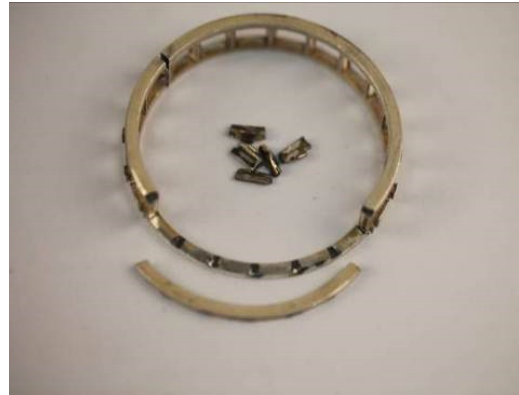
Figure 13. Macroscopic damage morphology of the cage.